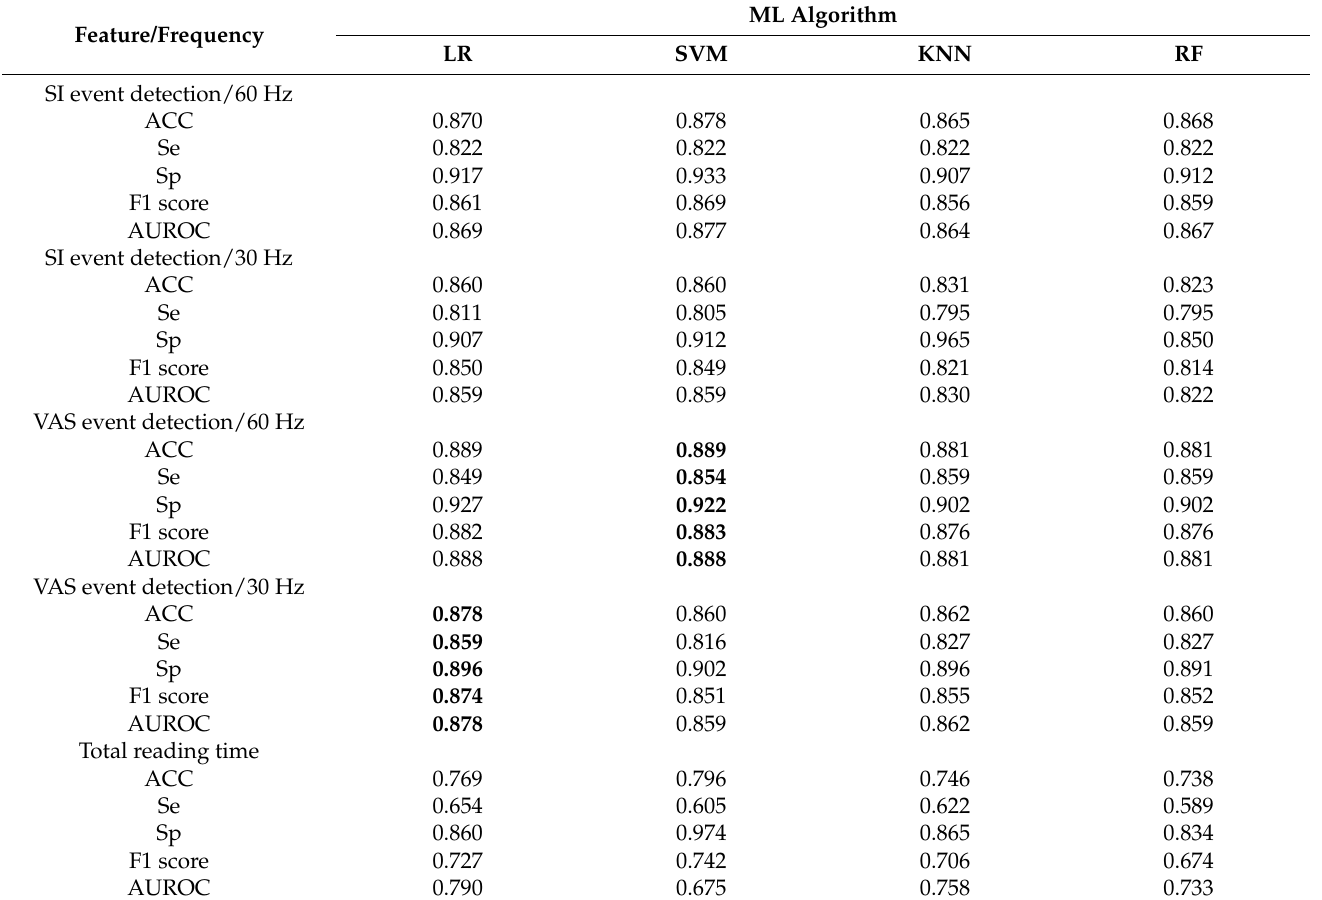
Table 1. Evaluation metrics on the test set for each feature and for all observed ML algorithms. ML Feature/Frequency